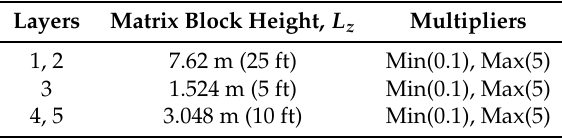
Table 1. The tested range of the matrix block